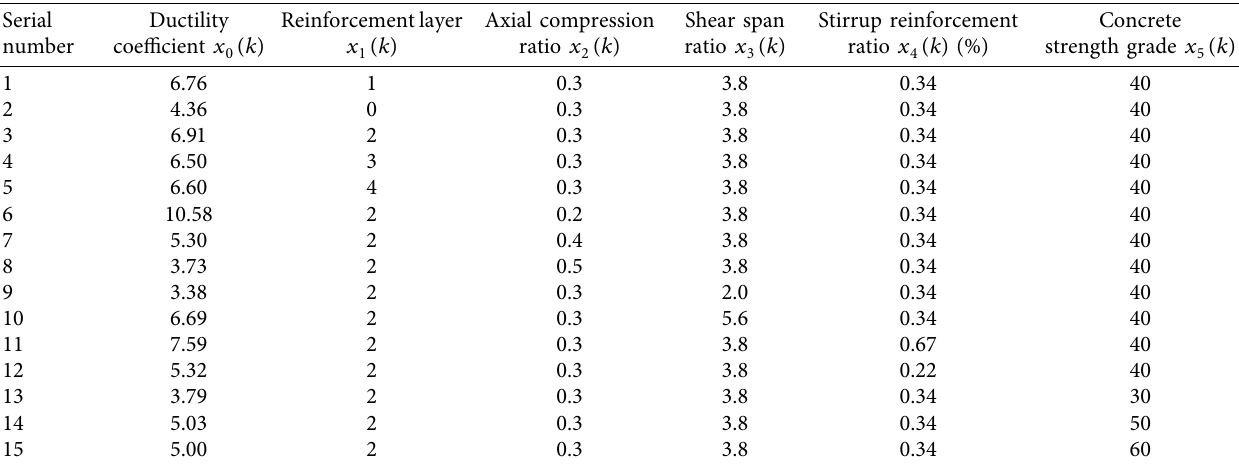
Figure 2: Hysteresis curves with different axial compression ratios of TRC-strengthened RC columns. (a) Axial compression ratios with 0.25. (b) Axial compression ratios with Table 1: Original data of the specimens.